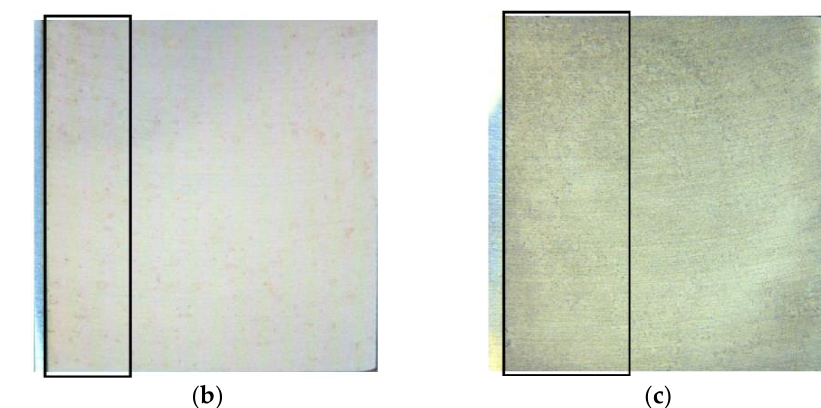
Figure 7. Images of calibration cell surfaces after 5 h exposure with 86 μ g NaCl/cm 2 load at 21 °C in ( a ) 85%, ( b ) 91%, and ( c ) 97% RH. Photographed cell surface has an area of 6.25 cm 2 (2.5 cm ×